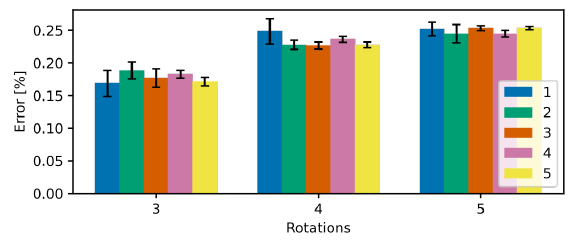
Fig. 10. Gyroscope calibration error by episode count and rotation